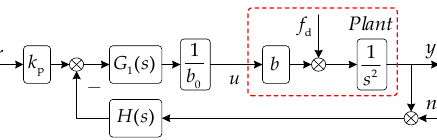
Figure 4. Simplified structure of the second-order LADRC.